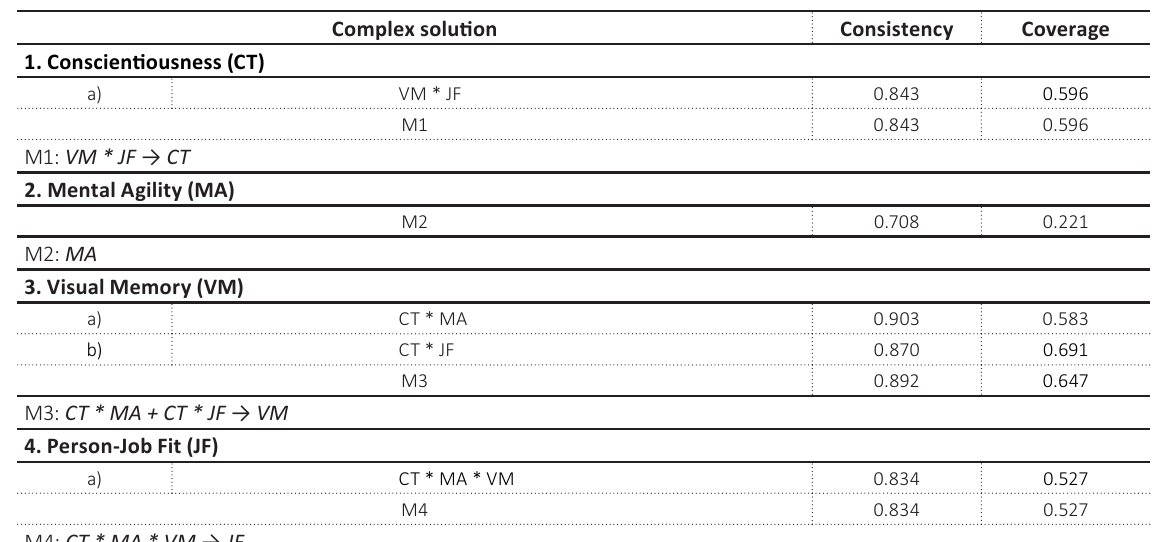
Table 4. fsQCA consistency and